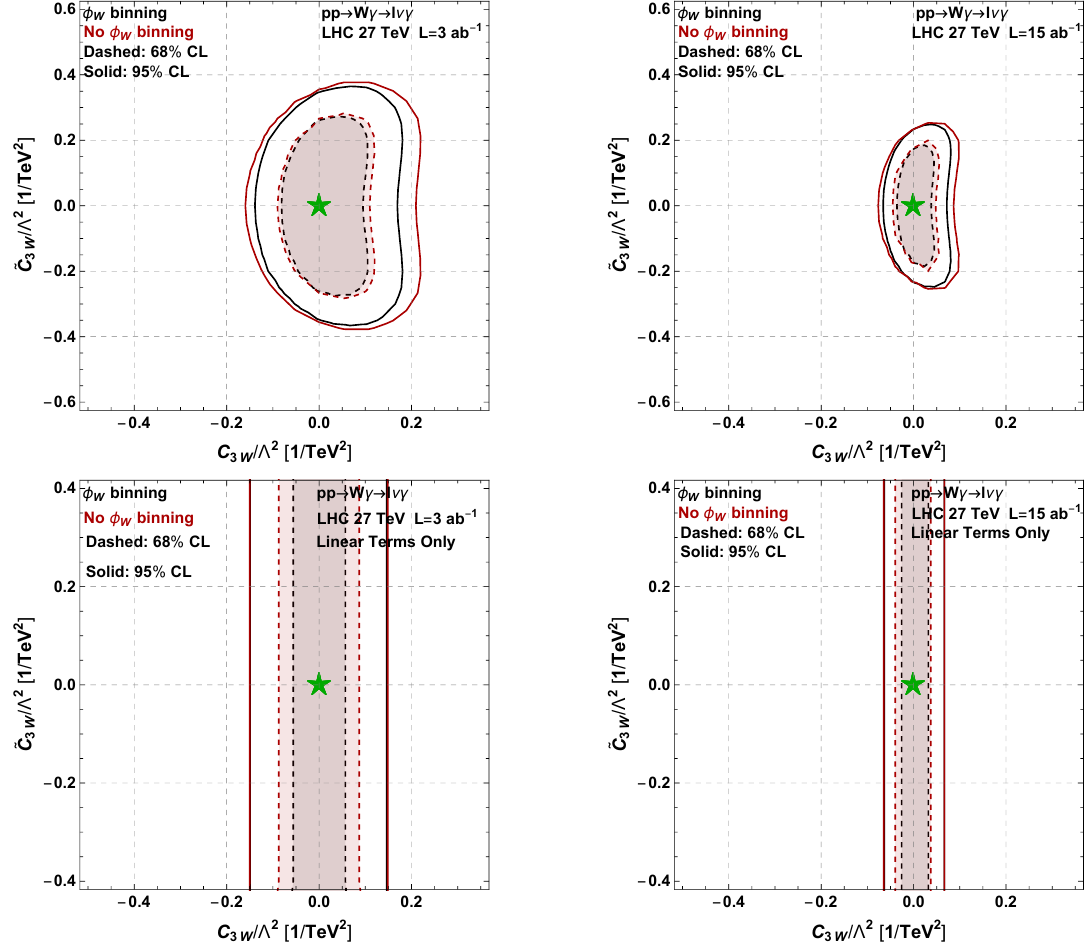
Figure 12 . 68% (dashed) and 95% (solid) posterior probability contours for the W(cid:13) at 27 TeV analysis with (black) and without (red) the binning in the (cid:30) W angle, see main text for more details. Only events with M W(cid:13) < 1 : 5 TeV are used. The upper and lower panels correspond to the limits T obtained with and without the inclusion of the quadratic term in the EFT expansion respectively.